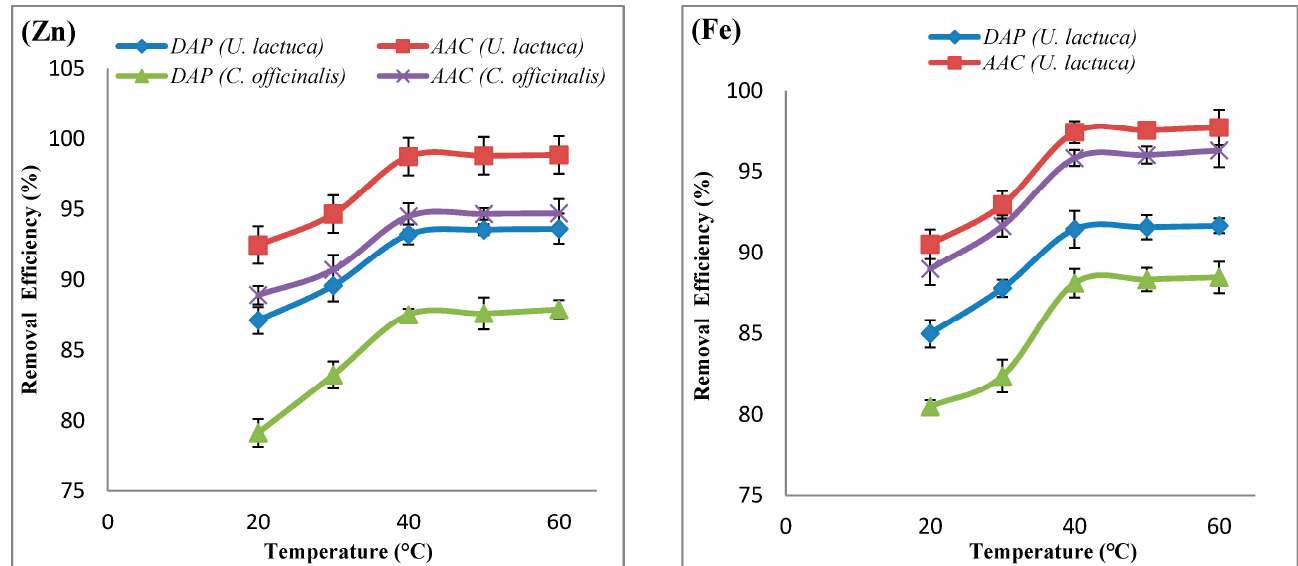
Figure 5. Effect of temperature on the percentage of removal of Zn +2 and Fe +3 (at 120 min., pH 5.0 by using 50 mg.L − 1 metal-ion concentration and 1.0 g.L − 1 ) using dried algal powder (DAP) and the activated carbon (AAC) of both U. lactuca and C. officinalis . Each data point represents the mean ± SD.